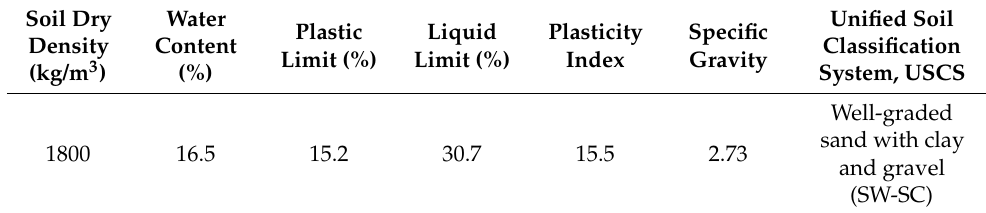
Table 1. Particle size distribution of the tested soils. Table 2. Physical properties of the tested soils.